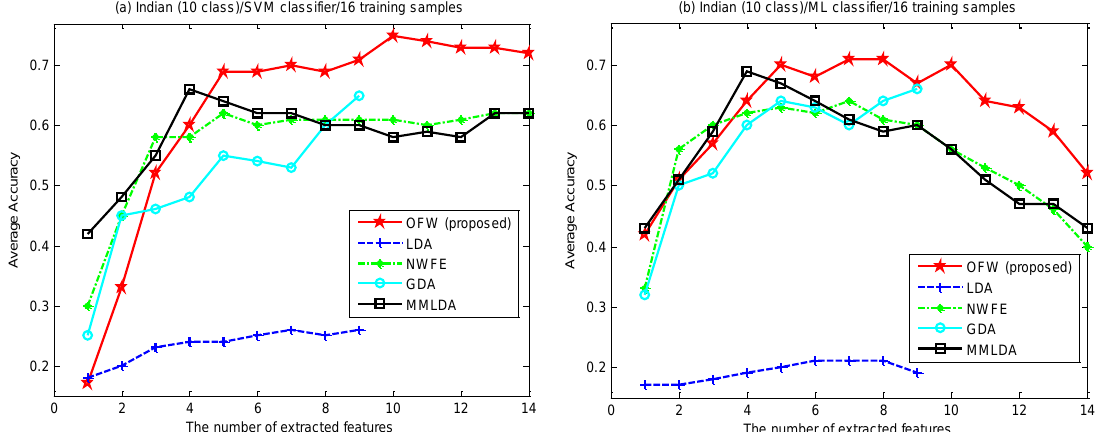
Figure 4. Average classification accuracy versus the number of extracted features obtained by a) SVM, b) ML classifiers for Indian dataset.